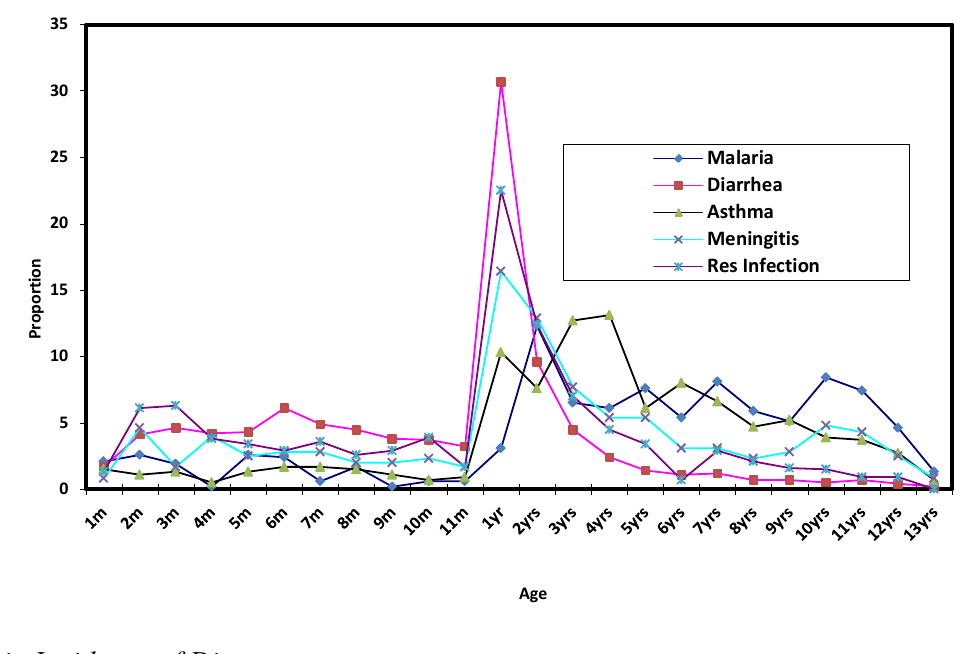
Figure 7. Relationship between age and incidence of